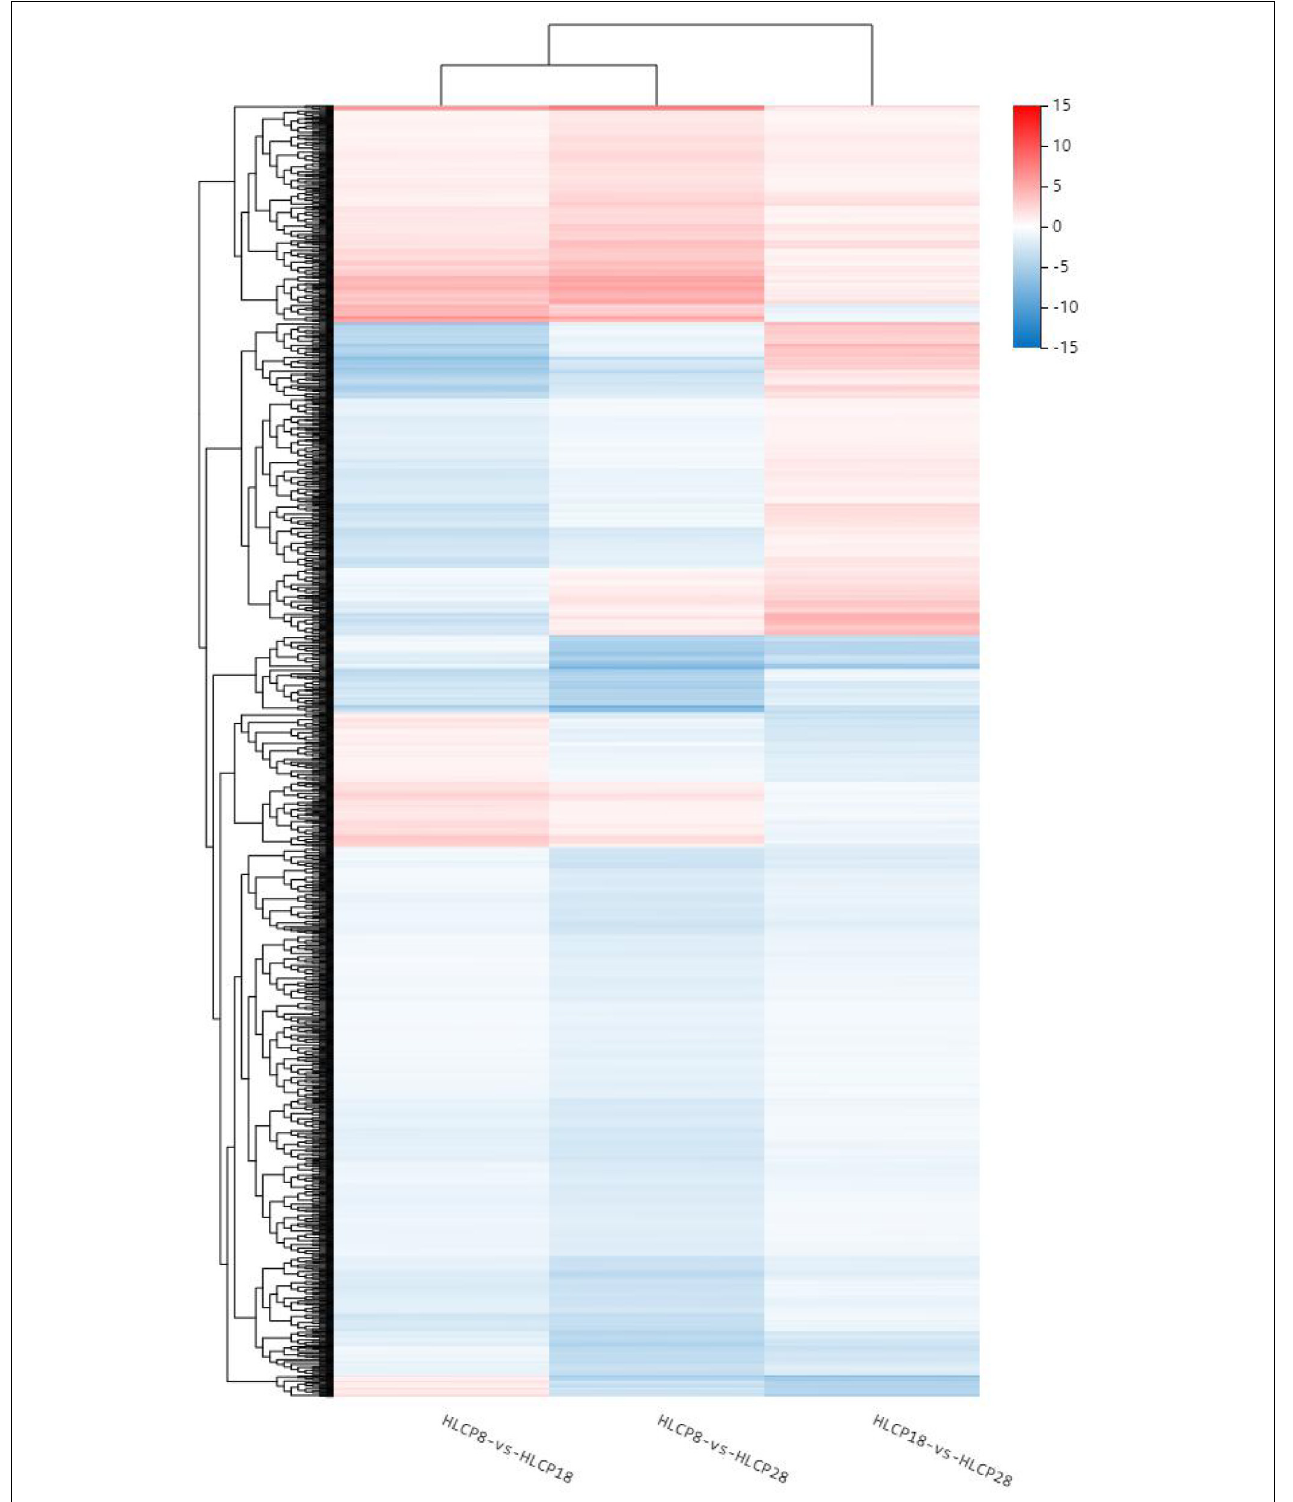
FIGURE 6 | Heatmap of GO cluster of 1,831 DEGs in the seed coat of hull-less C. pepo L.